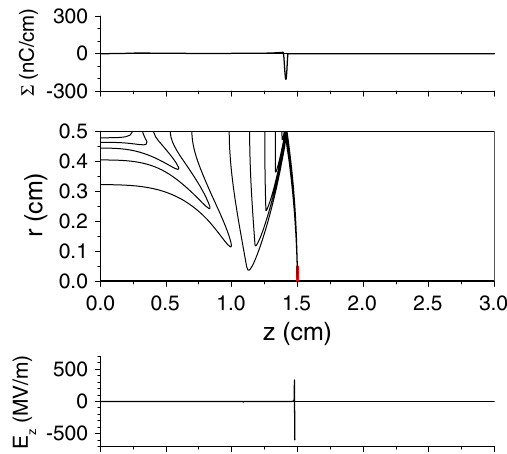
FIG. 9. Flux lines, axial electric field on the beam axis, and the lineal surface charge density of the wakefield in the dielectric- ¼ 10 d . filled cavity when z b